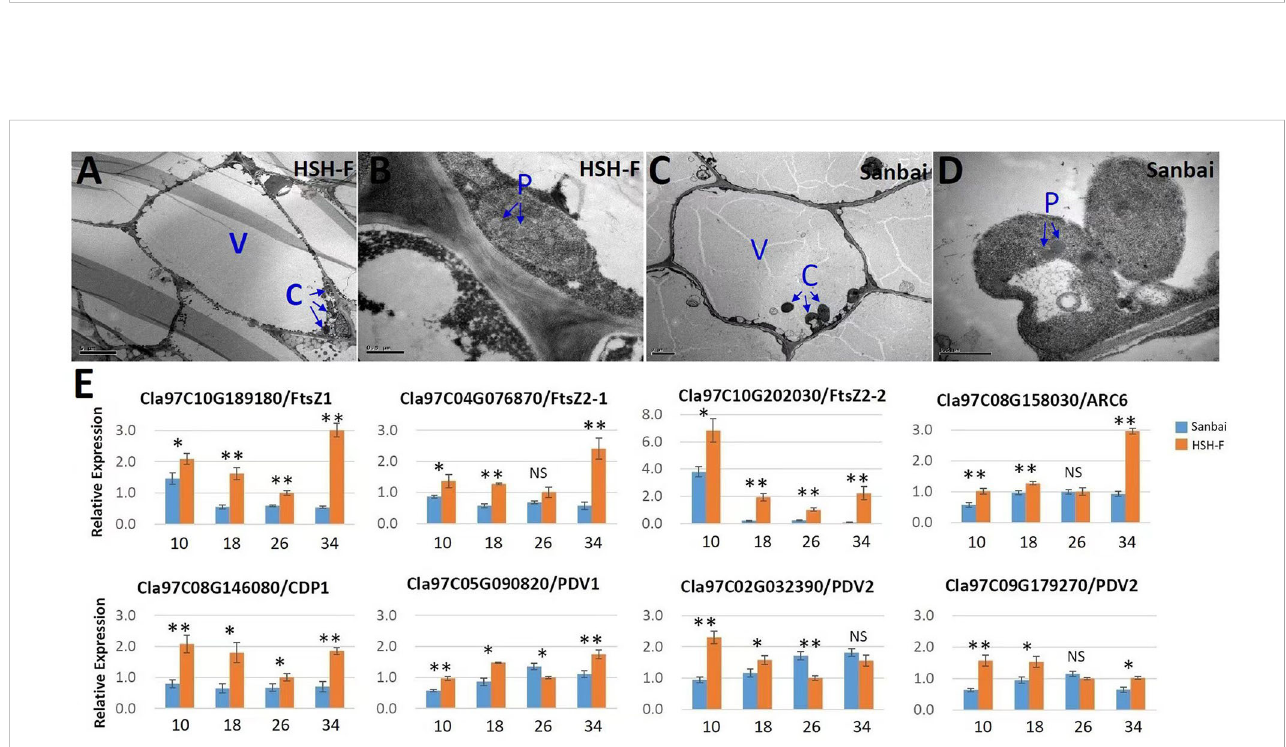
FIGURE 5 (A – E) Transmission electron microscopy of chromoplasts (A – D) and relative expression of the chromoplast proliferation-related genes (E) . (A, B) Micrographs of HSH-F fruit cells at 34 days after pollination (DAP): whole-cell view (A) and detailed view of chromoplasts (B) . (C, D) Micrographs of Sanbai fruit cells at 34 DAP: whole-cell view (C) and detailed view of chromoplasts (D) . V , vacuole; C , chromoplast; P , plastoglobule. Error bars indicate the mean ± SD ( n = 3). Signi fi cant difference between the two parents at each stage was assessed using Student ’ s t -test. * p < 0.05; ** p < 0.01. NS, no signi fi